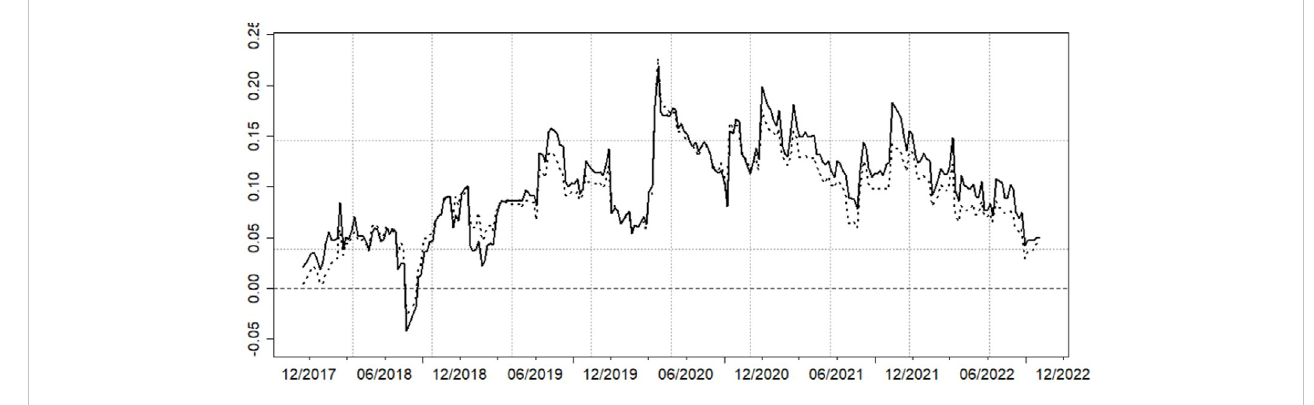
FIGURE 10 Comparison between cross-equicorrelations of baseline estimation and estimation with a smaller